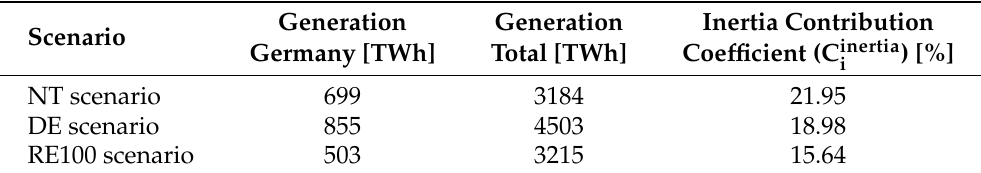
Table 5. Overall power generation in Continental Europe and Germany as well as the calculated inertia contribution coefficient. Data from